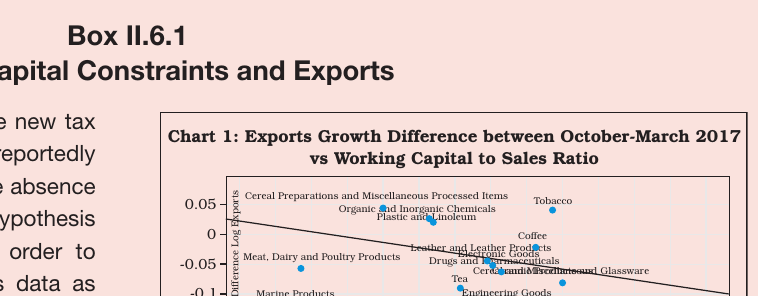
Chart 1: Exports Growth Difference between October-March 2017 vs Working Capital to Sales Ratio